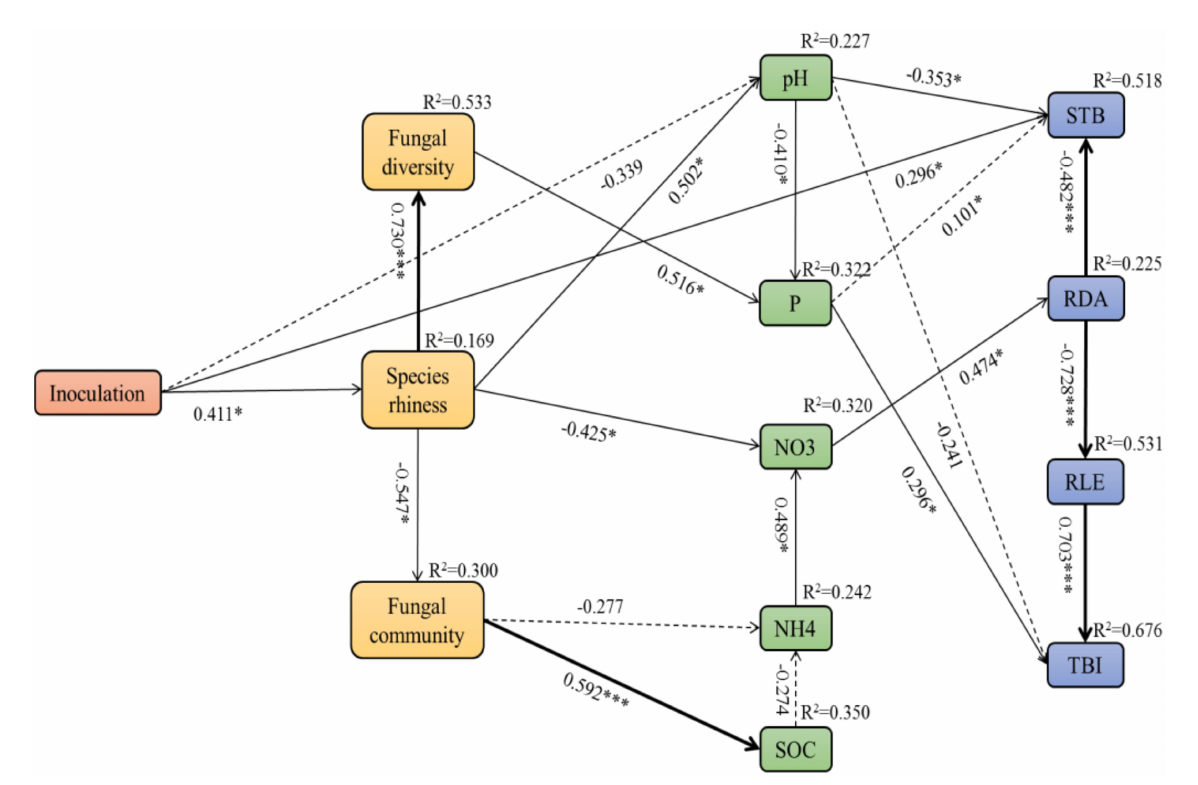
FIGURE9 Structural equation model (SEM) showing the causal relationships among soil fungal community, soil factors, and plant growth parameters of A. adsurgens associated with different inoculation treatments. The solid lines and dashed lines indicate significant and non-significant pathways, respectively. The width of the solid lines indicates the strength of the causal effect, and the numbers near the arrows indicate the standardized path coefficients. Significant values are indicated by *( p < 0.05), **( p < 0.01), and ***( p < 0.001). The numbers in the upper-right corner of the box indicate the R 2 values and represent the proportion of variance explained for each variable. P, soil available phosphorus; SOC, soil organic carbon; NO 3 , soil nitrate; NH 4 , soil ammonia; STB, stem branching numbers; RLE, root length; RDA, root diameter; TBI, total